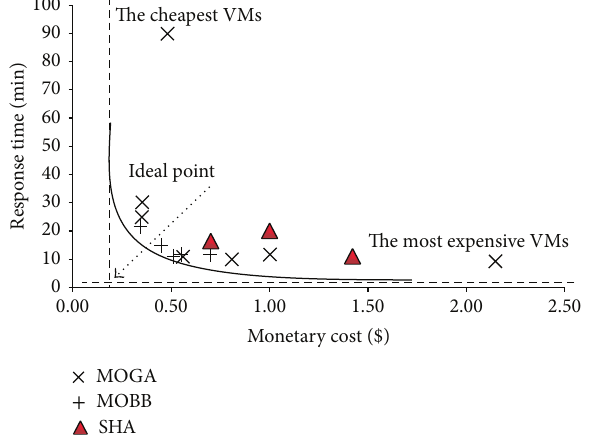
Figure 17: Proposed paretooptimal solutions for workload 3 by SHA, MOBB, and MOGA